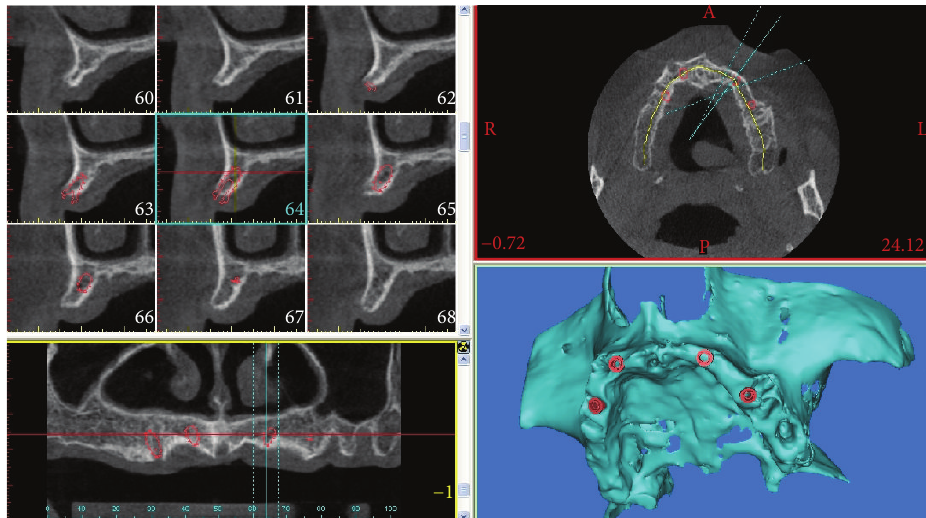
Figure 2: Three-dimensional (3D) reconstruction of the maxilla by means of implant navigation software, with virtual planning of implant